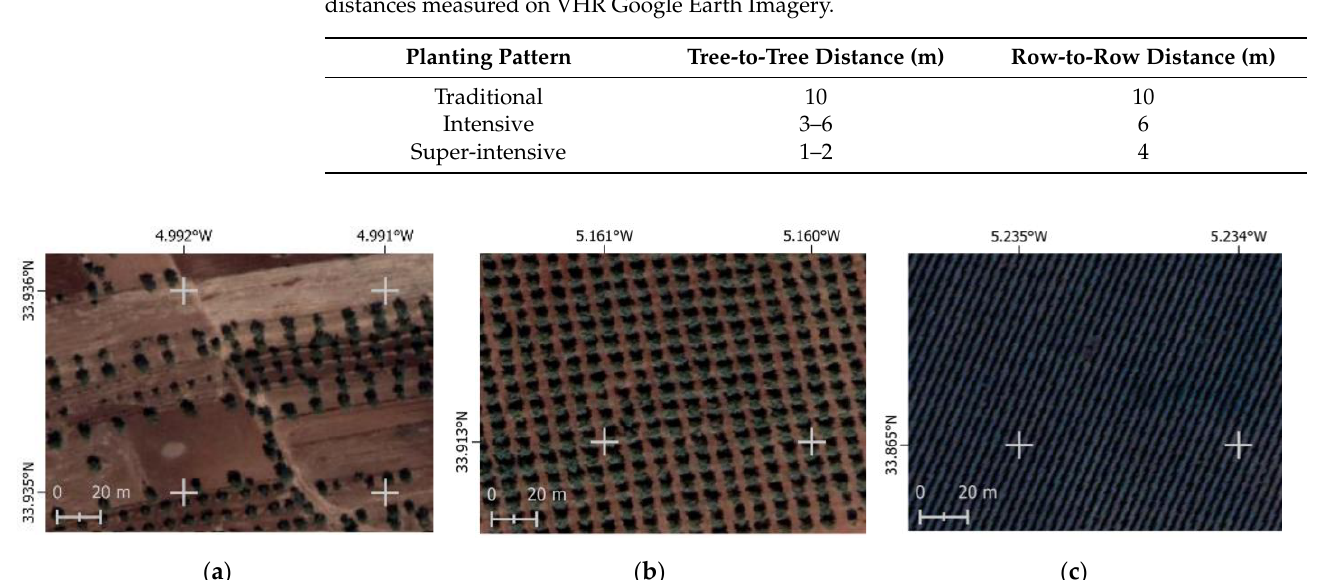
Figure 6. VHR images showing varying tree-to-tree and row-to-row distances within different orchard management types: ( a ) traditional, ( b ) intensive, ( c ) and super-intensive or SHD. Source: Google Earth Images 2022.